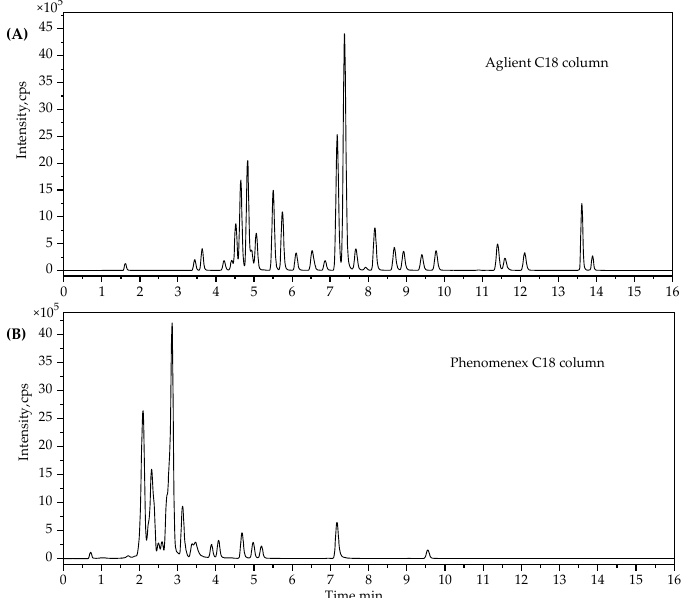
Figure 5. Total ion chromatogram (TIC) of two different kinds of columns. ( A ) is for the Agilent C 18 column and ( B ) is for the Phenomenex C 18 column, a mixed standard solution of 100 µ g/kg PAs was used in this test.